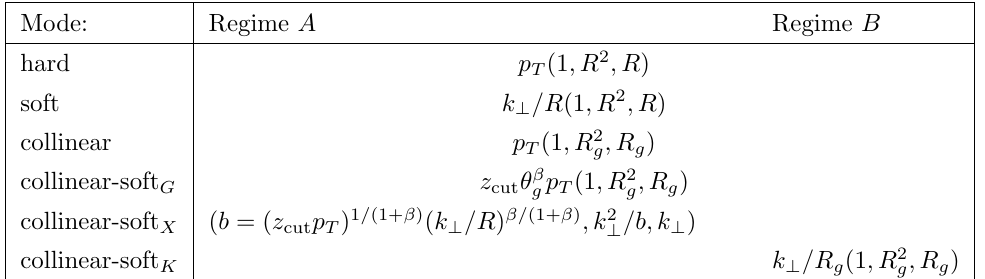
Table 3 . The modes that enter in the factorization of for the angle between the standard and G groomed jet axis, when k z cut p T R . Regime A ( B ) correspond to R g smaller (larger) than ? (cid:28) [ k R (cid:12) = ( z cut p T )] 1 = (1+ (cid:12) ) ?